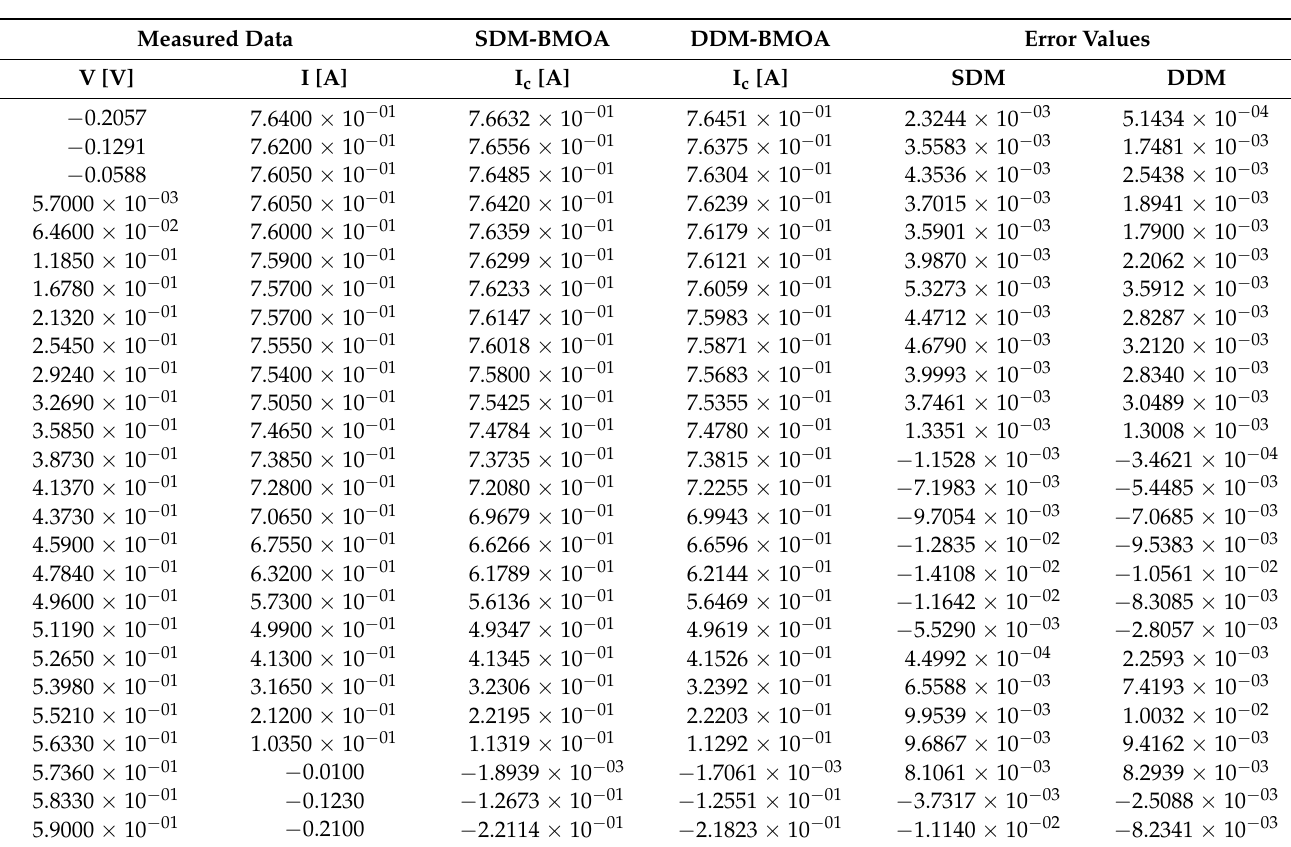
Table 8. (I, V) points of RTC silicon photovoltaic cell.